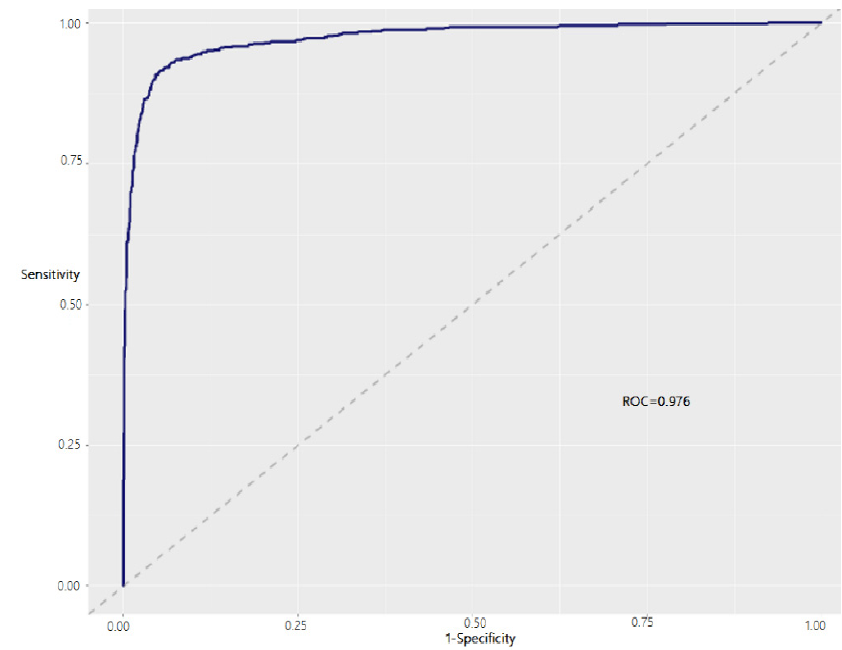
Figure 8. ROC curve for text classification using LASSO regularized regression.